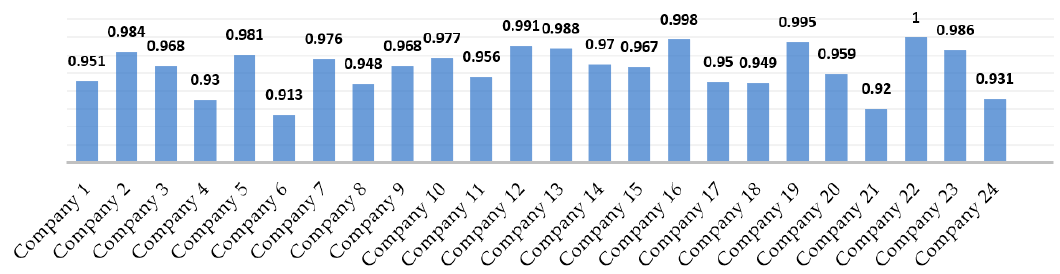
ffi ciency for FDH